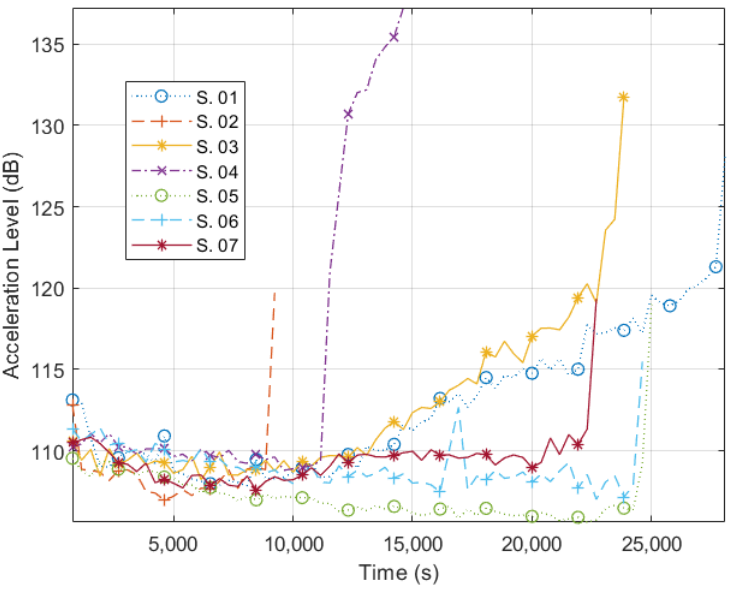
Figure 2. Moving average (MA) plots of 7 vibration signals are shown in the form of acceleration level (dB) across time (s), for condition 1 of the bearing dataset [62]. The MA interval is 512 points and a reference level of 1 µ m/s 2 was used, as per [66]. Table 1. Timing characteristics of datasets. Sample Bearing